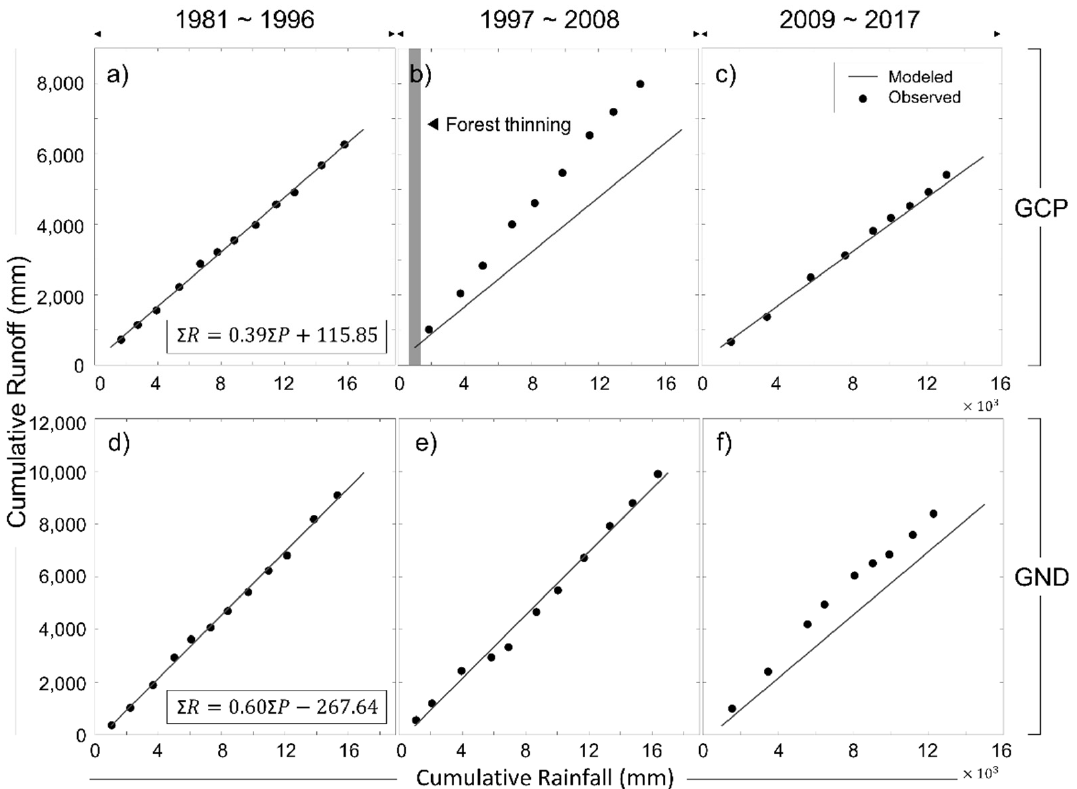
Figure 7. Simple linear regression model of double mass curve and observed values in the GCP ( a – c ) and the GND ( d – f ) forest catchments. In the second period in the GCP forest catchment (1997~2008) after forest thinning was conducted, there is a radical discrepancy between the observed and modelled runo ff .